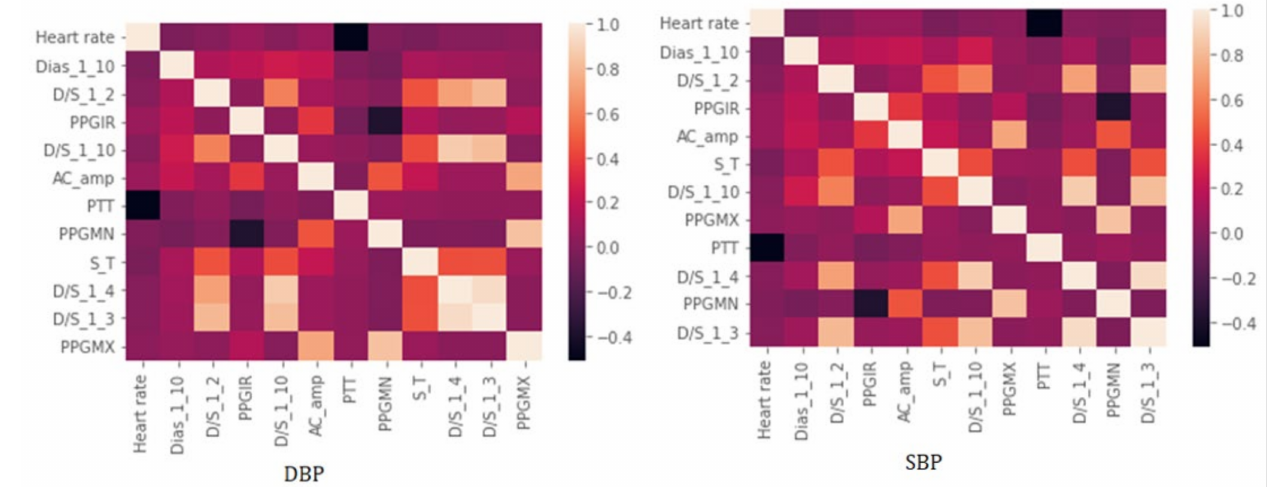
Figure 14. The Pearson’s coefficient value among finalized features using a heat map.